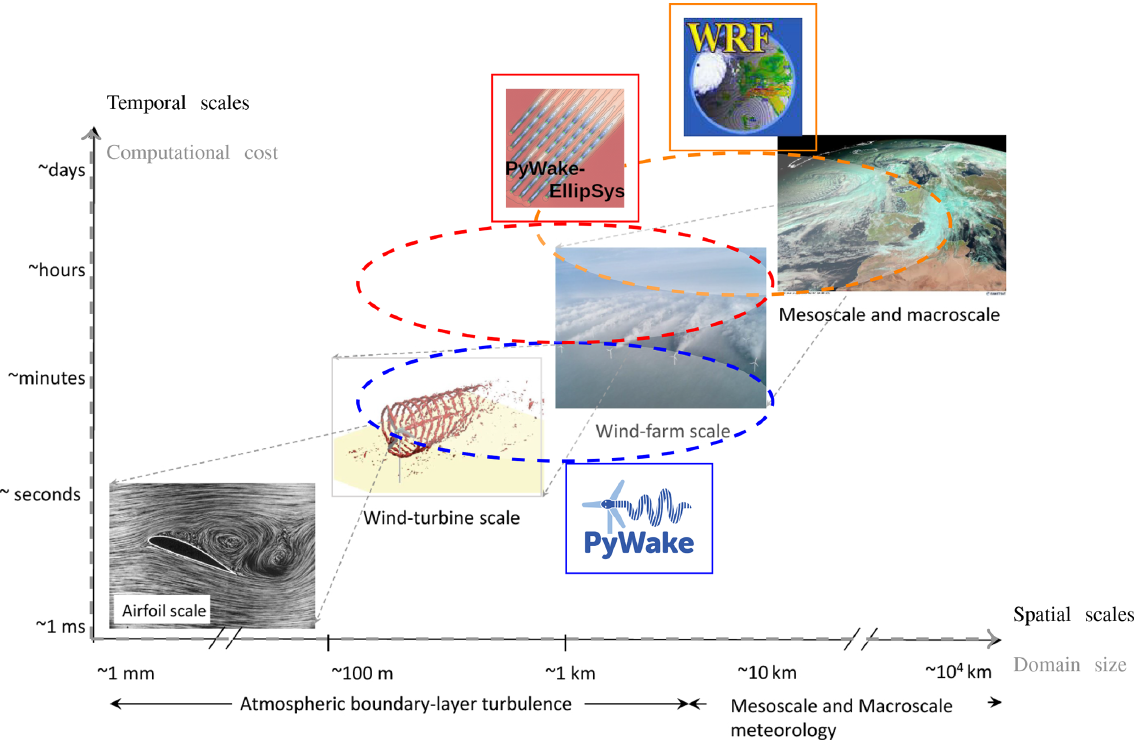
Figure 1. Scales relevant for wind energy and targeted models with their associated resolution and computational costs. Taken from Porté- Agel et al. (2020) in accordance with the Creative Commons Attribution (CC BY) license with modifications. Table 1. Characteristics of simulated wind farms in Fig. 2. Farm Centre lon. Centre lat. No. Hub Rotor Rotor Turbines height diameter (m) (m)